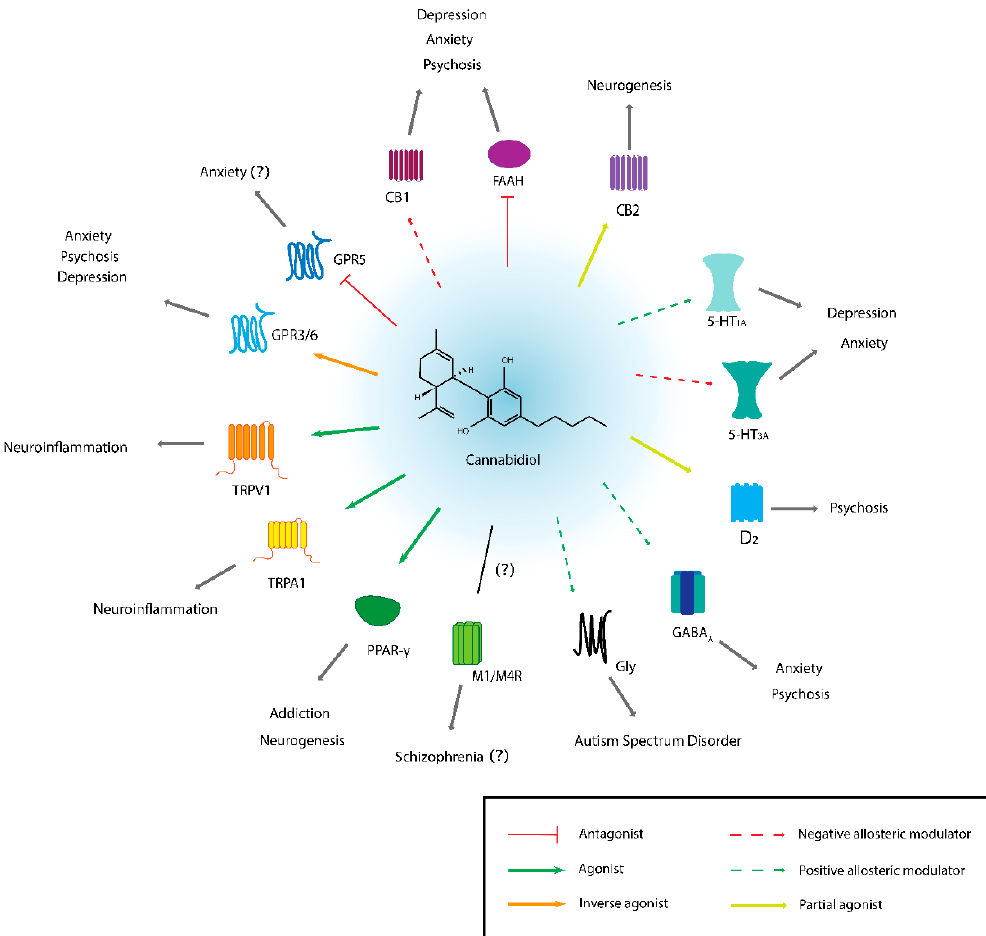
Figure 1. Summary of molecular targets of CBD relevant to psychiatry. For each molecular target, the activity of CBD is indicated by either solid or dotted coloured lines (with the except of the muscarinic receptors M1 and M4, where CBD’s pharmacological activity is not clear). Question marks indicate limited or uncertain evidence. TRPV1 and TRPA1 are both involved in neuroinflammation (which is especially relevant for epilepsy and pain), and this may link their activity to depression, addiction, or other mental health conditions [18], though the evidence is limited. For detailed reviews of CBD molecular targets, the interested reader is directed to references [18,20,26].